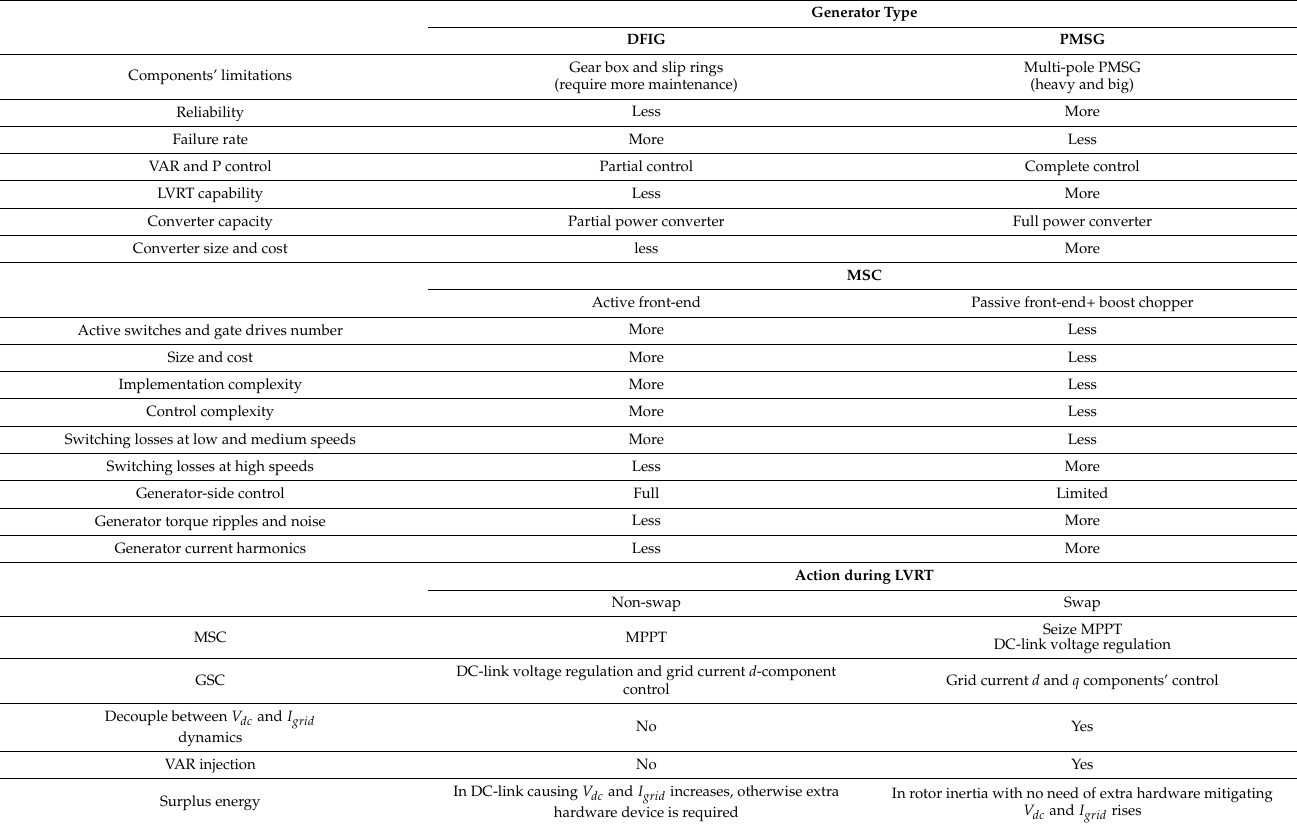
Table 6. Comparison between the considered WECS components and applied control versus those of classical WECS systems